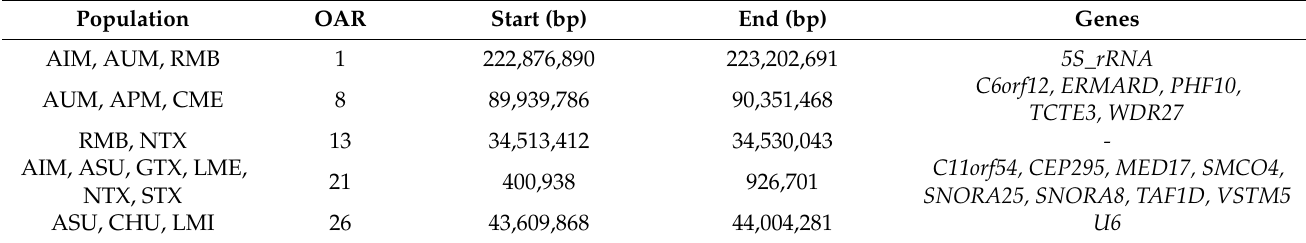
Table 6. Common genomic regions and candidate genes in HRR islands for two or more worldwide sheep populations.